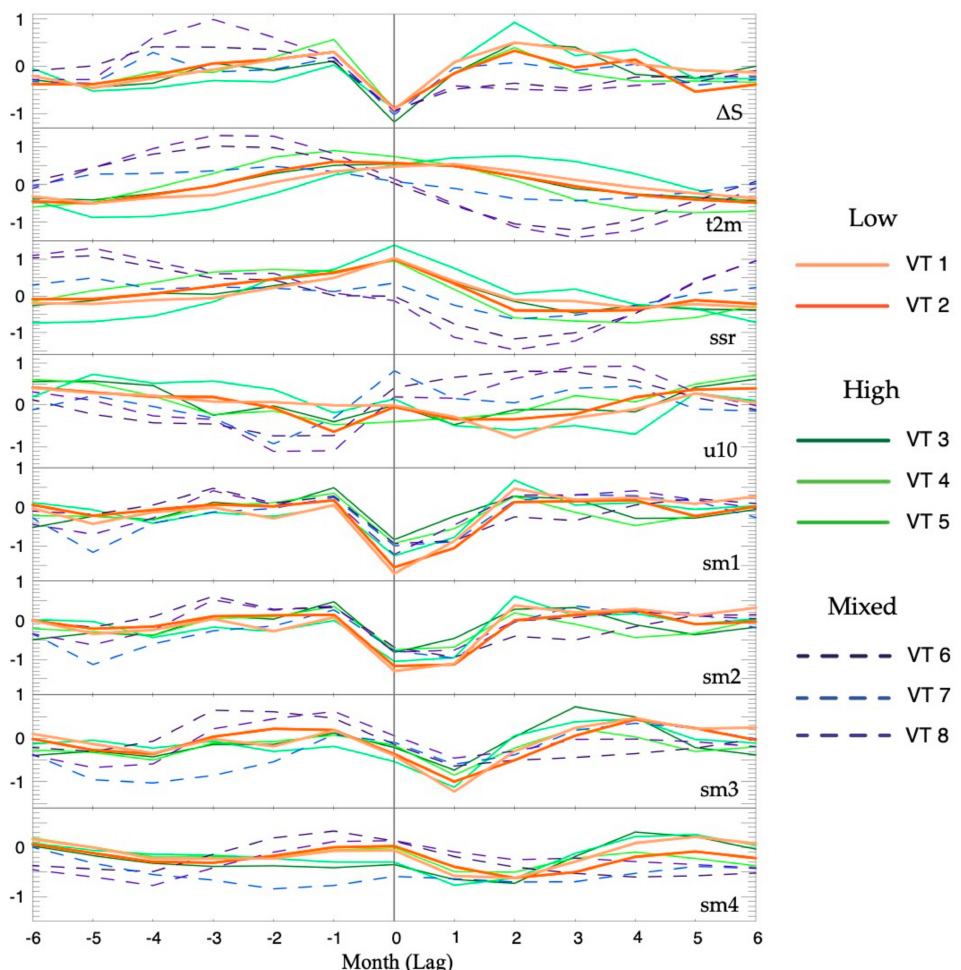
Figure 7. Parameters subjected to the composite analysis based on the ten minimum ∆ S cases for each vegetation type (orange, green, and blue tones correspond to low, high, and mixed vegetation, respectively). t2m, 2 m air temperature; ssr, surface solar radiation; u10, 10 m U-component of